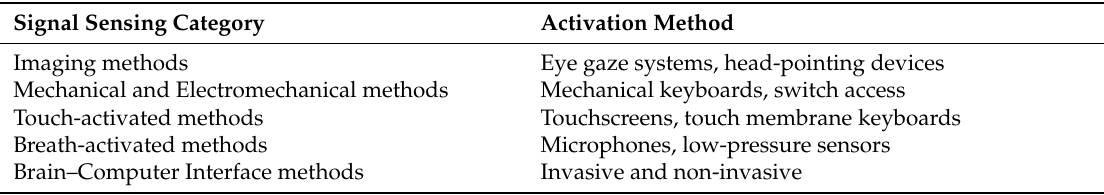
Table 1. Sensing modalities of AAC